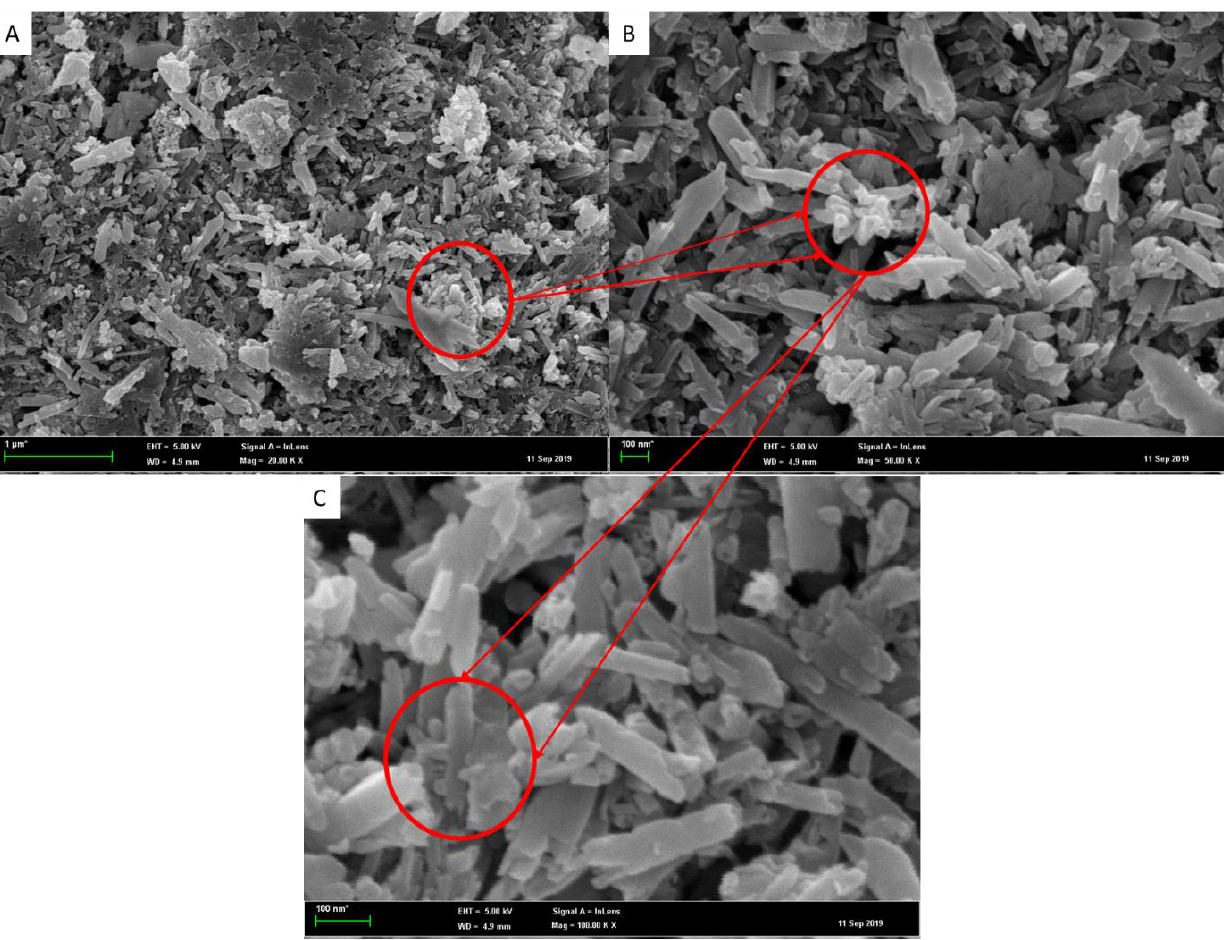
Figure 1. FESEM images of CTS-Si/HNT nanocomposite in ( A ) 20,000×, ( B ) 50,000×, and ( C ) 10,000× magnification.